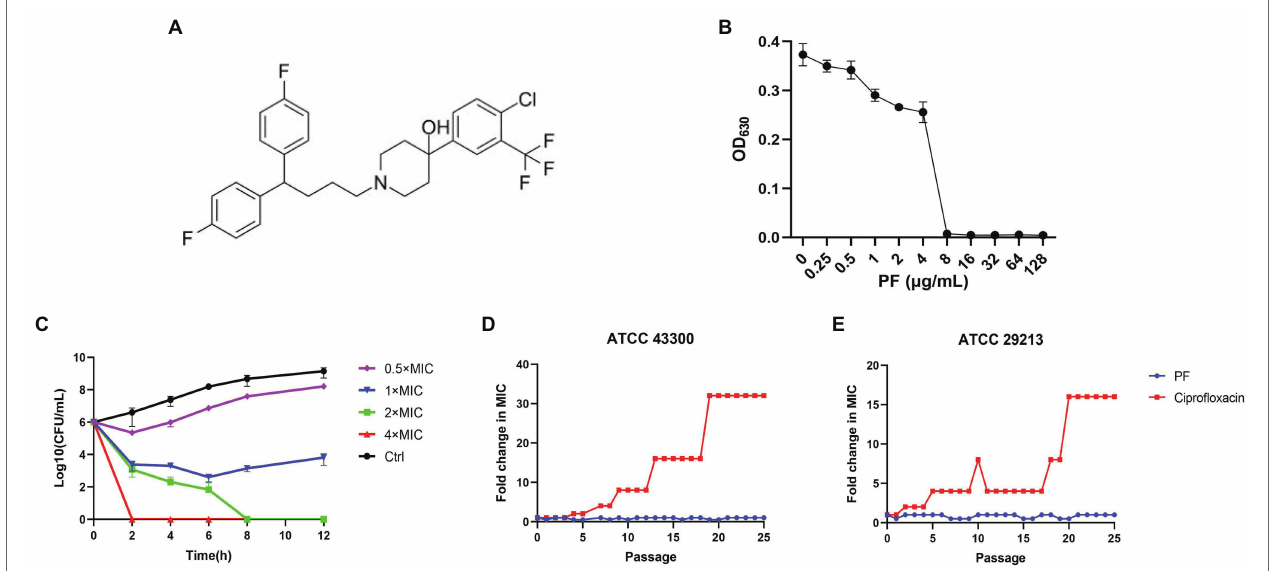
FIGURE 1 | Penfluridol (PF) shows bactericidal activity against Staphylococcus aureus and without detectable resistance development. (A) The chemical structural formula of PF. (B) The growth of S. aureus ATCC 43300 after exposure to PF for 16–18 h. (C) Time killing curve of PF against S. aureus ATCC 43300, S. aureus was treated with 0.5–4× MIC of PF or 0.1% DMSO (control). Samples were harvested and counted at 0, 2, 4, 6, 8, and 12 h, the experiments were conducted triplicate and presented as mean ± SD. Sequential passaging resistance development of (D) S. aureus ATCC 43300 and (E) ATCC 29213 to PF and ciprofloxacin (CIP).